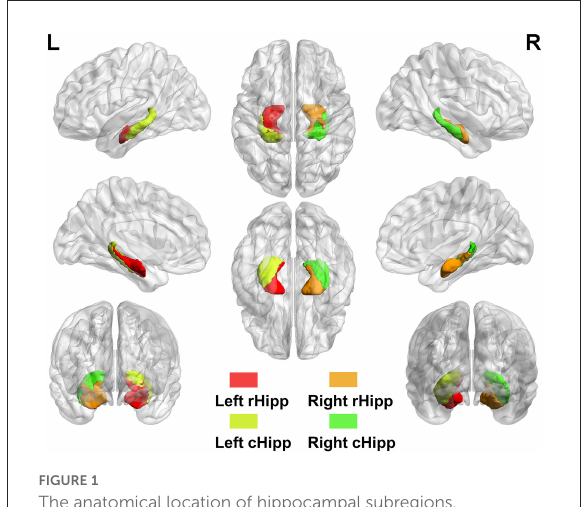
FIGURE1 The anatomical location of hippocampal subregions. Hippocampal subregions based on the Human Brainnetome Atlas, including left rostral hippocampus (rHipp), right rostral hippocampus (rHipp), left caudal hippocampus (cHipp), and right caudal hippocampus